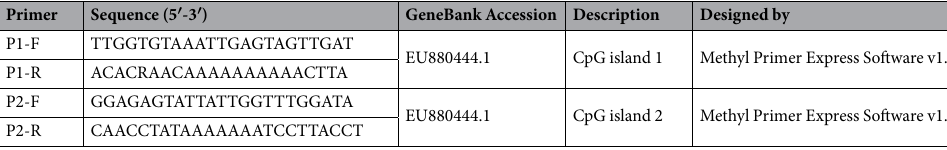
Table 3. Primers for bisulfite